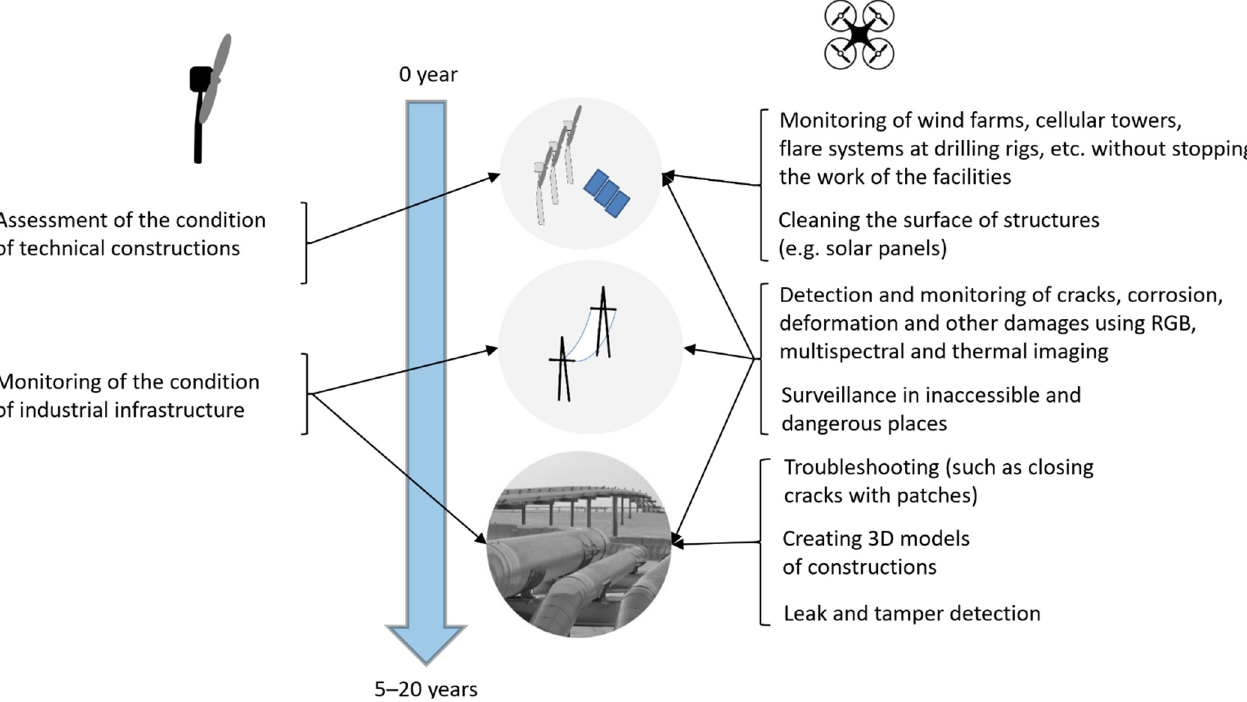
Figure 8. Using UAVs for monitoring of technical and engineering structures. Source: Generated by the authors.